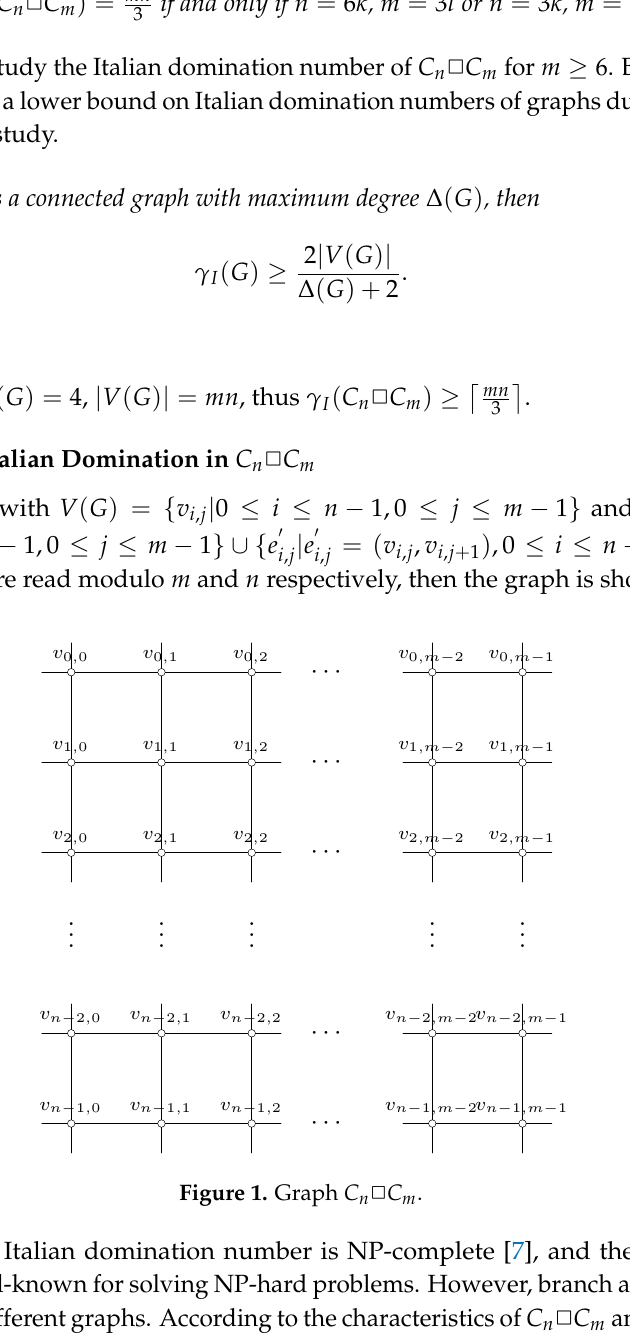
2 C . Figure 1. Graph C n (cid:50) C m n m